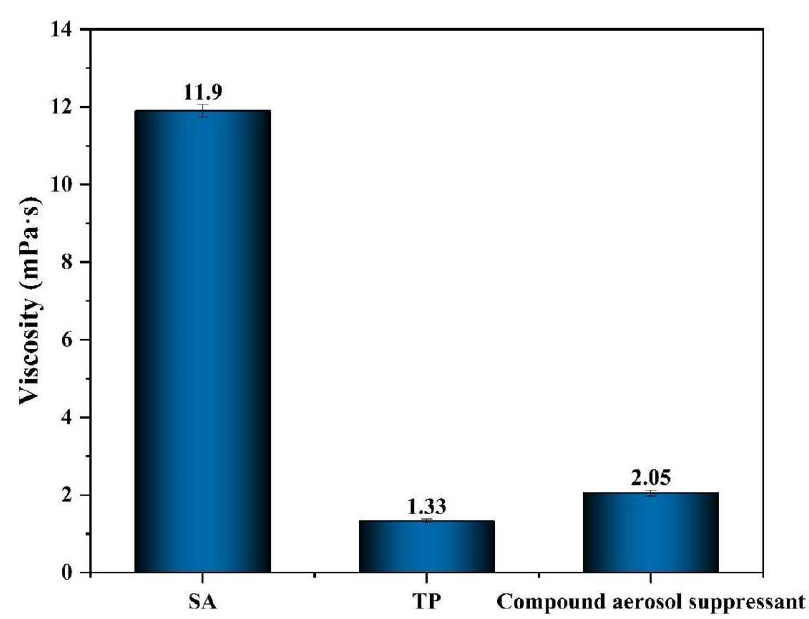
Figure 5. Viscosity of different aerosol-suppressant solutions.